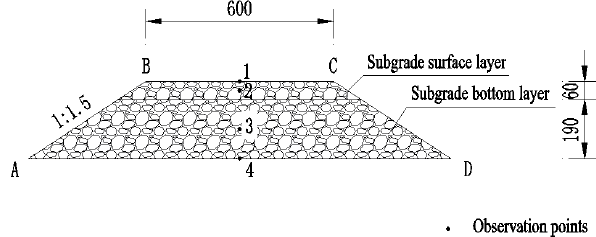
Figure 8. The calculation model with fluid-solid two-phase coupling. Appl. Sci. 2020 , 10 , x FOR PEER REVIEW